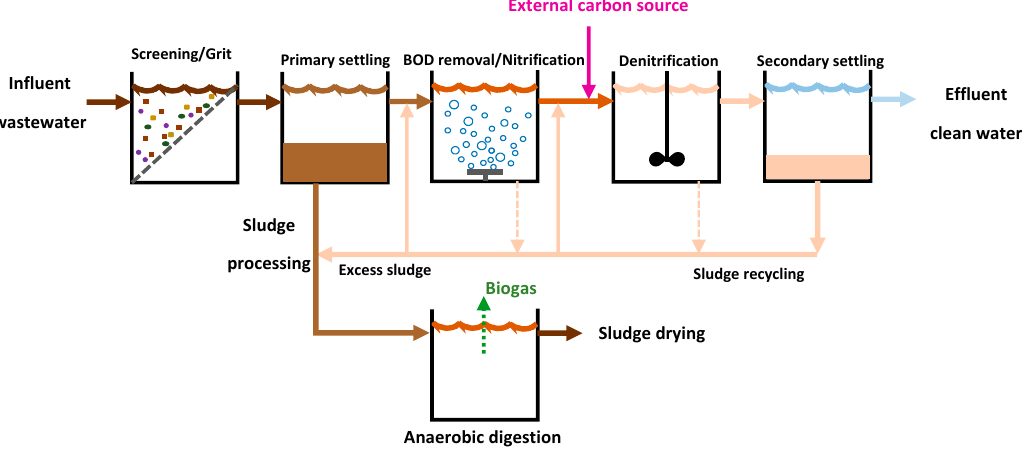
Figure 1. General processing stages at a conventional wastewater treatment plant aimed at biogas production from excess sewage sludge.